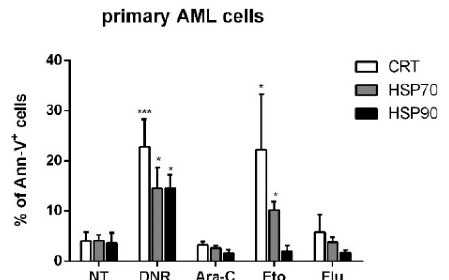
Figure 2. Flow cytometry analysis of calreticulin (CRT) and heat-shock protein (HSP) translocation on the cell-surface of acute myeloid leukemia (AML) cells after chemotherapy treatment. The HL-60, KG-1 and primary AML cells were treated with daunorubicin (DNR) (500 ng / mL), cytarabine (Ara-C) (20 µ g / mL), etoposide (Eto) (20 µ g / mL) and fludarabine (Flu) (70 µ g / mL) for 24 h. The percentage of CRT + , HSP70 + and HSP90 + cells (gated on apoptotic Ann-V + cells) was analyzed by flow cytometry. Un-treated cells (no treatment; NT) were used as a negative control. The values are represented as mean ± SEM of 5 independent experiments. * p < 0.05; ** p < 0.01; *** p < 0.001; **** p < 0.0001 compared to un-treated cells.